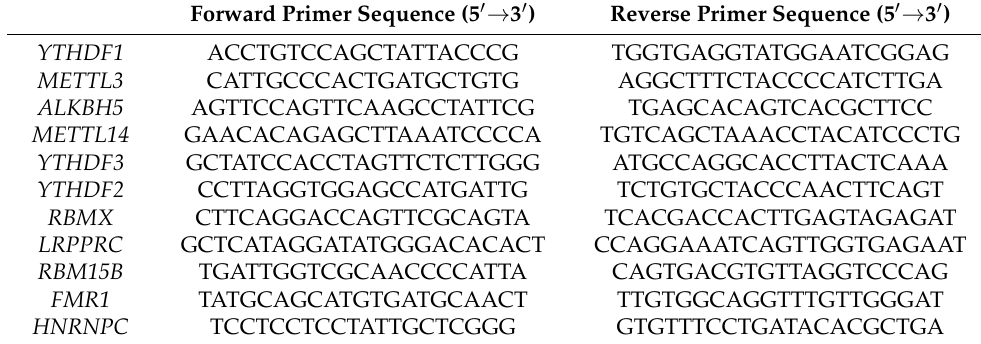
Table 2. The primer sequences of 11 significant m6A